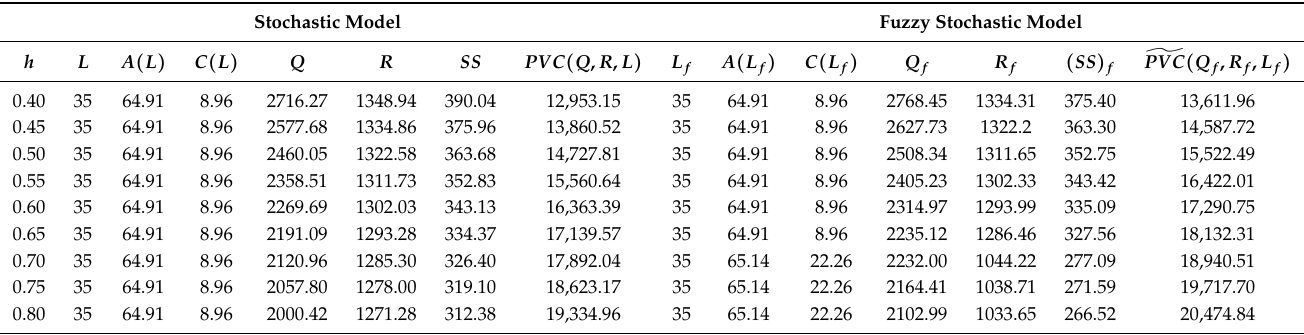
Table 7. Effect of the holding cost in the stochastic and fuzzy stochastic models.